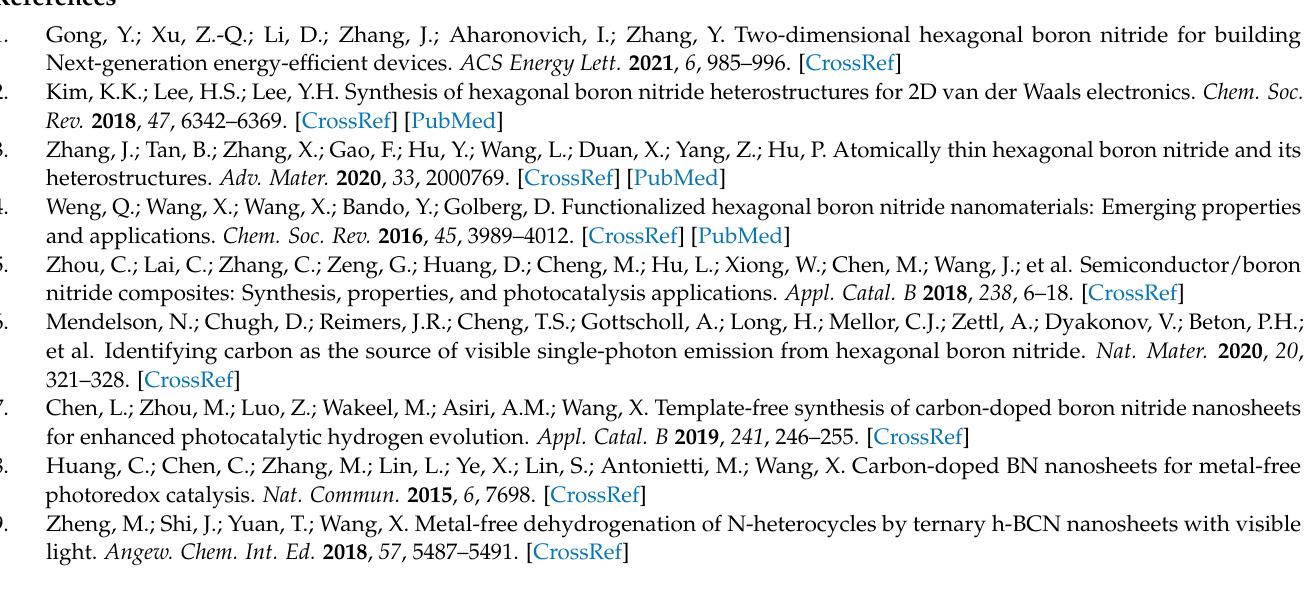
structure refinement for M · 2B; Figure S1. Arrangements of melamine and boric acid molecules in the crystal of M · 2B; Figure S2. (a) Raman and FTIR spectra of M · 2B (black line), P1 (red line), and P2 (blue line): (b) in the 500~4000 cm − 1 region: (c) in the 3000~3600 cm − 1 region; Table S2. Spectral data (cm − 1 ) and band assignments of M · 2B, P1 and P2; Table S3. Chemical shifts of 13C of glucose, P1, and P2; Figure S3. TGA thermograms of M · 2B, P1 and P2 samples: (a) from 40 to 1000 ◦ C in N2; (b) from 40 to 300 ◦ C in N2; and (c) DSC curves of M · 2B, P1, and P2 samples from 40 ◦ C to 1000 ◦ C in N2; Figure S4. (a) The SEM image of p-BCN-1, inset: the diameter distribution histogram. (b) HRTEM image of p-BCN-1; Figure S5. Morphologies of the p-BN: (a) TEM (scale bar: 500 nm); (b) HRTEM (scale bar: 10 nm); and (c) Measured the layer distance of the red rectangle of (b); Table S4. Physical and textural properties of p-BN, p-BCN-1, and p-BCN-2; Figure S6. Powder XRD patterns of calcined product p-BCN-1 of the P1 at different temperatures; Figure S7. FTIR spectra of the calcined product p-BCN-1 of P1 at different temperatures; Figure S8. XPS high-resolved spectra of p-BN, (a) B 1s and (b) C 1s; Table S5. The peak position and relative atomic percentage of various functional groups in p-BN, p-BCN-1, and p-BCN-2 samples; Figure S9. UV–vis diffuse reflectance spectra of the calcined product p-BCN-1 of P1 at different temperatures; Figure S10. (a) Plots of ε 0.5/ λ versus 1/ λ based on the optical absorption data from p-BN, p-BCN-1, and p-BCN-2 samples, respectively. VB-XPS spectra of (b) p-BN, (c) p-BCN-1, and (d) p-BCN-2; Figure S11. Schematic illustration of the band structures of p-BN, p-BCN-1, and p-BCN-2 samples; Figure S12. Photocatalytic activities over the p-BN, p-BCN-1, and p-BCN-2 samples: (a) CO production, (b) H2 production, and (c) CH4 production; Figure S13. Photographic synthesis of the p-BCN samples by two different cooling modes; Figure S14. Cooling curves of (a) P1 and (b) P2.